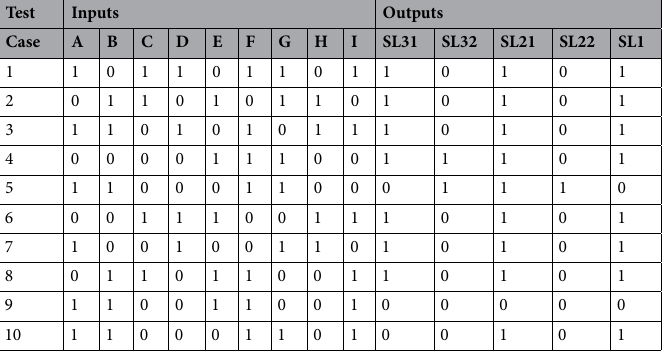
Table 10. Truth table for secure CMOS circuit